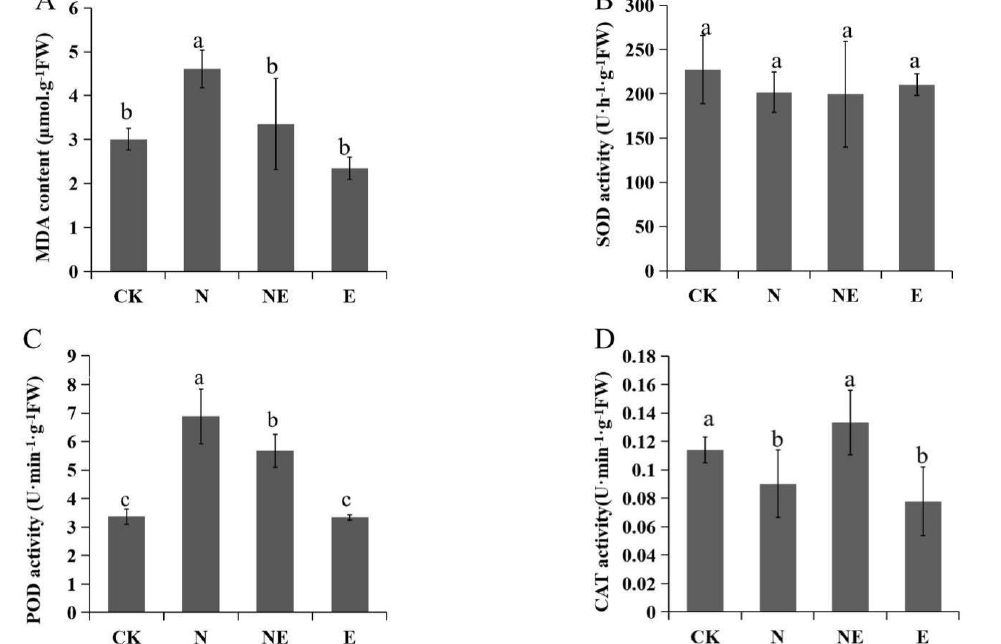
Figure 3. Effects of EBL on MDA content and antioxidant enzyme activities of peanut seedlings under NaCl stress. CK (normal conditions), N (treated with 150 mM NaCl), NE (treated with 150 mM NaCl and 0.1 µ M EBL) and E (treated with 0.1 µ M EBL). ( A ) MDA content; ( B ) SOD activity; ( C ) POD activity; ( D ) CAT activity. Different lowercase letters indicate significant differences between treatments ( p <